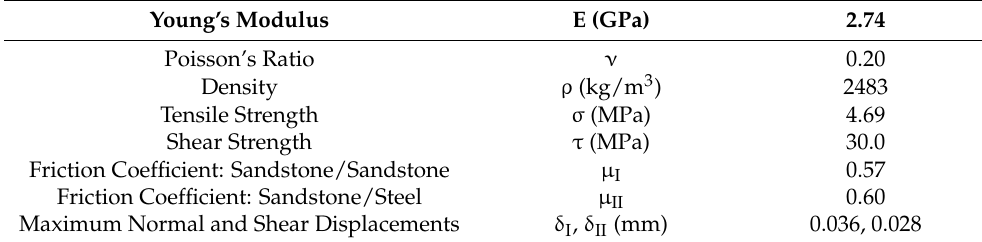
Figure 4. Geometric representation of ( a ) a confined Brazilian test and ( b ) a uniaxial compression test to be used in numerical computations. Table 1. Sandstone Material Properties used in HOSS Simulations.